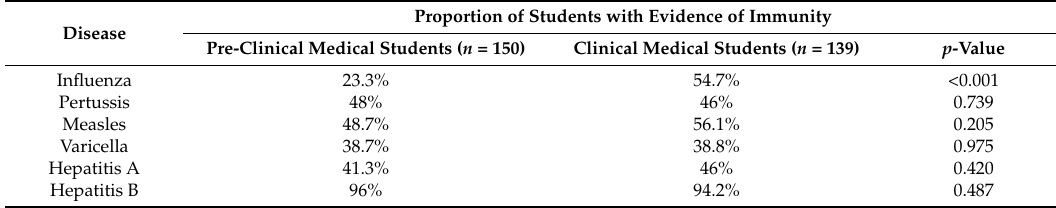
Table 4. Rates of documented immunity among year level groups. Proportion of Students with Evidence of Immunity Disease Pre-Clinical Medical Students ( n =